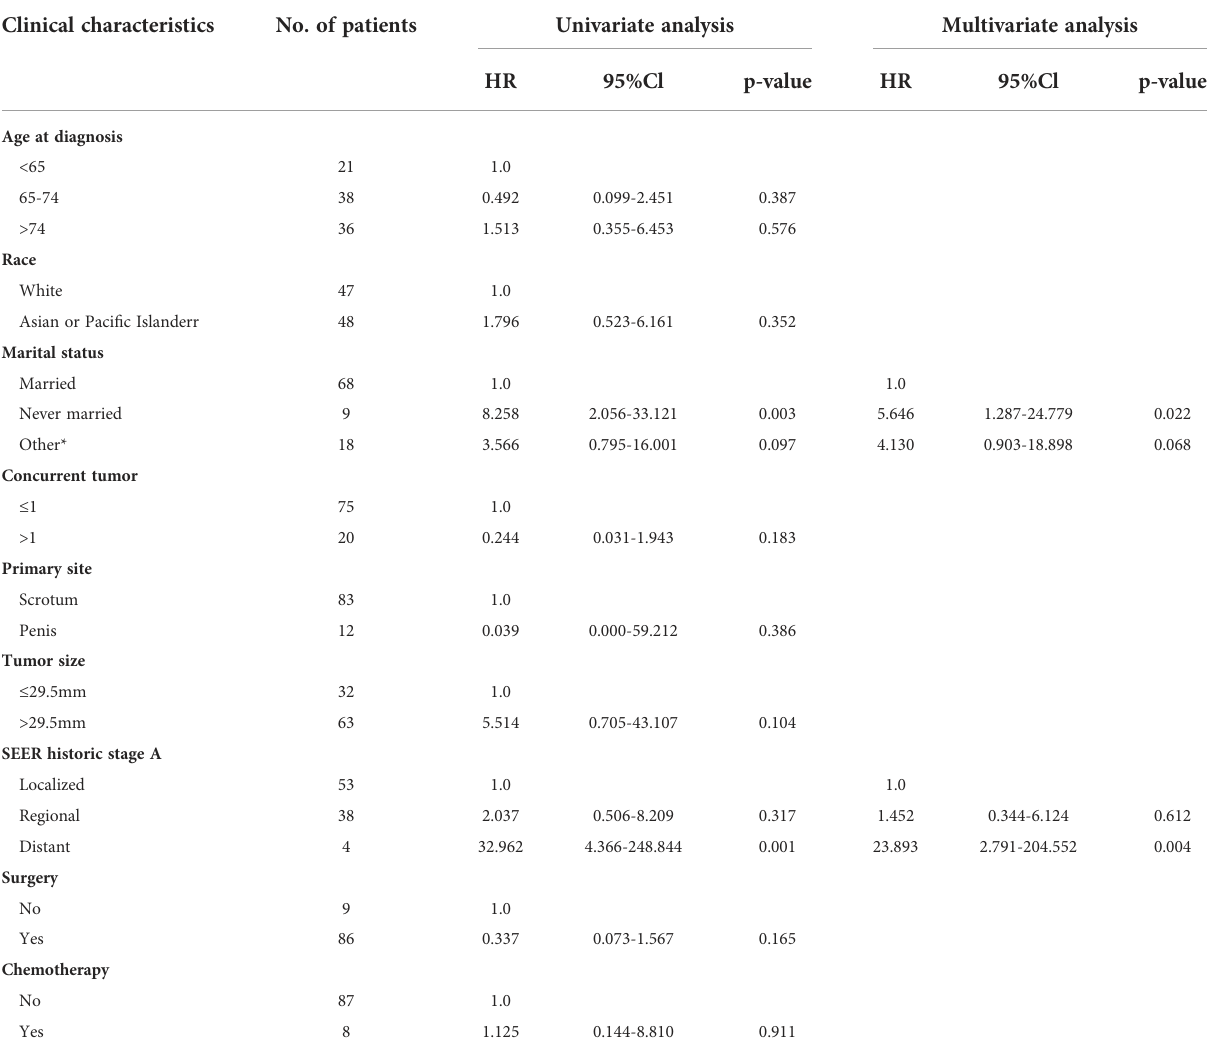
TABLE 2 Univariate and multivariate analyses of CSS in the training cohort. Clinical